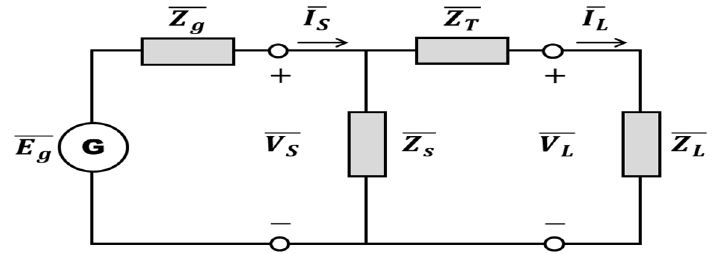
Figure 4. Thévenin equivalent circuit model of power system. Figure 4. Th é venin equivalent circuit model of power